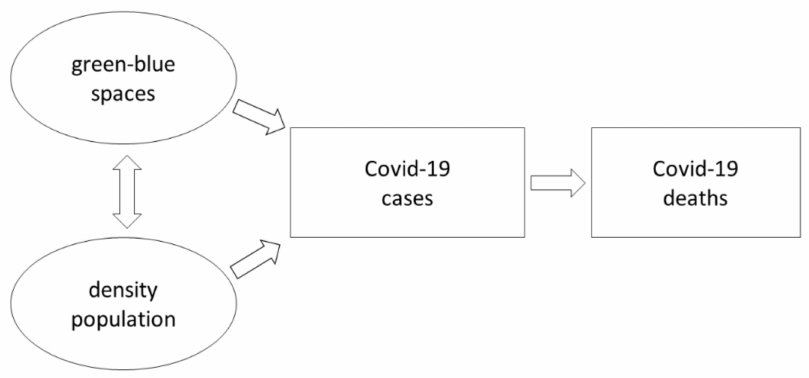
Figure 1. Schematic diagram of